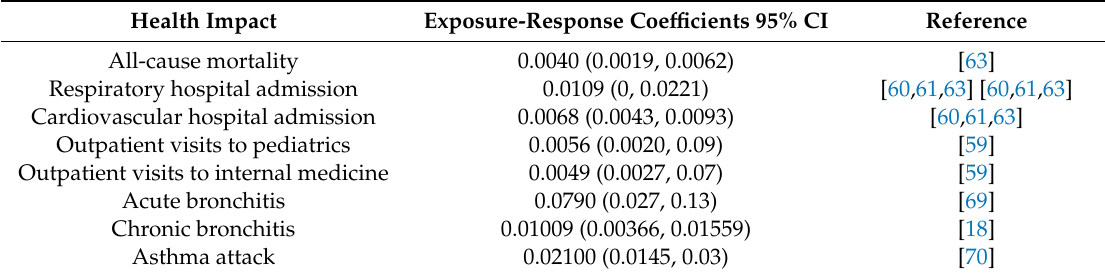
Table 1. PM 2.5 exposure-response coe ffi cients for the chosen health